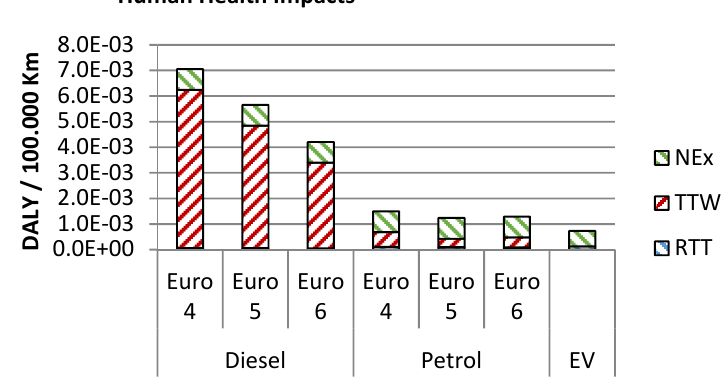
Figure 10. DALY per km driven in an urban environment.